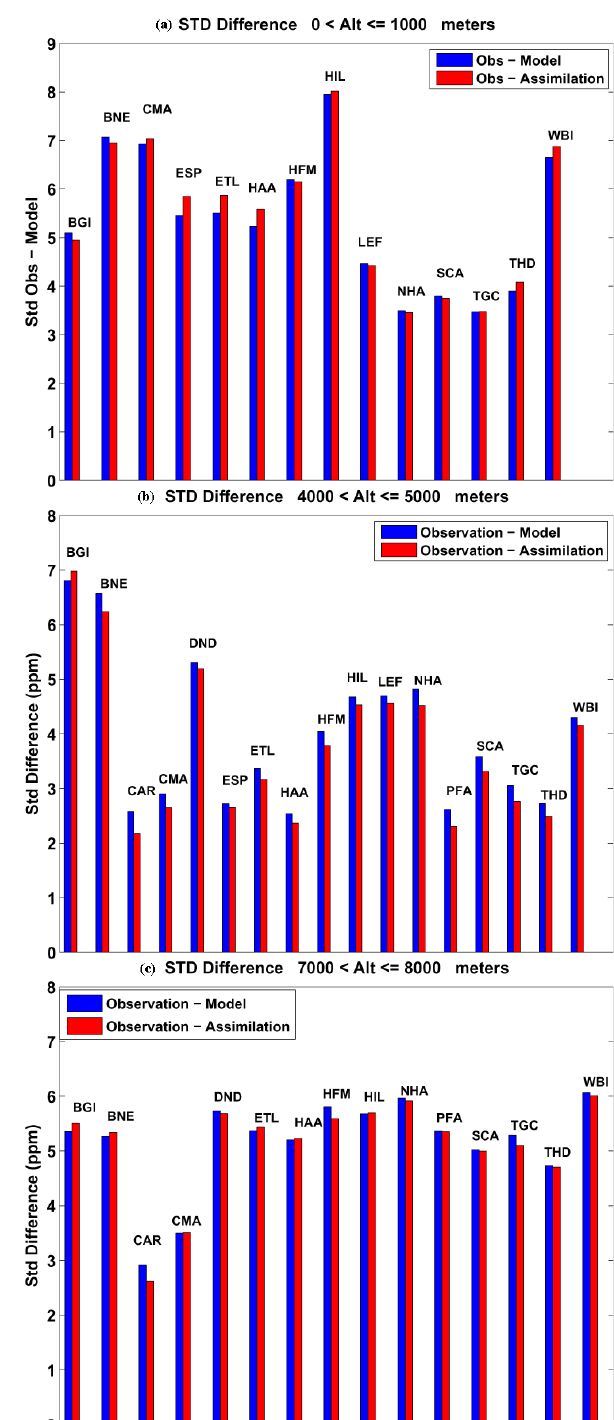
Fig. 9. Standard deviation of difference between the NOAA/ESRL aircraft data and CO 2 from the GEOS-5 model (or assimilation) interpolated to the observation locations, during the period 1